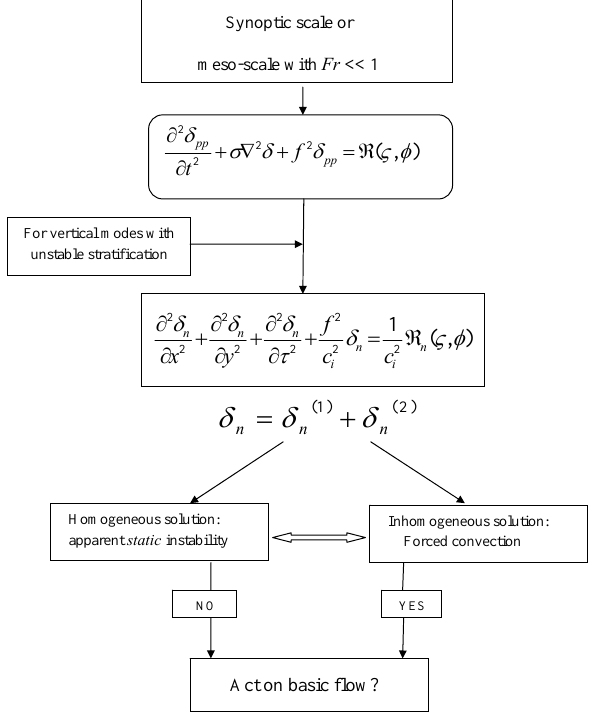
Figure 3. A schematic overview about the different cases discussed in Section 3. Fig. 3. A schematic overview about the different cases discussed in Sect.